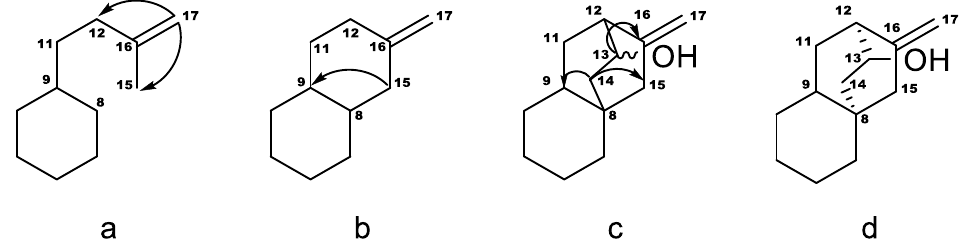
Figure 2. Structure elucidation for the 13( S )-hydroxyatisenoic acid. The arrows indicate cross-peaks in the HMBC spectrum between protons at the start position and carbons at the end position.